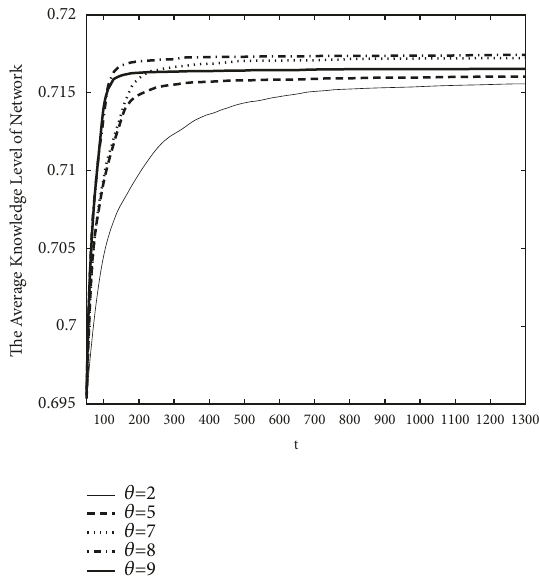
Figure 4: When 𝛼 = 0.8 network average knowledge levelevolution diagram under different 𝜃